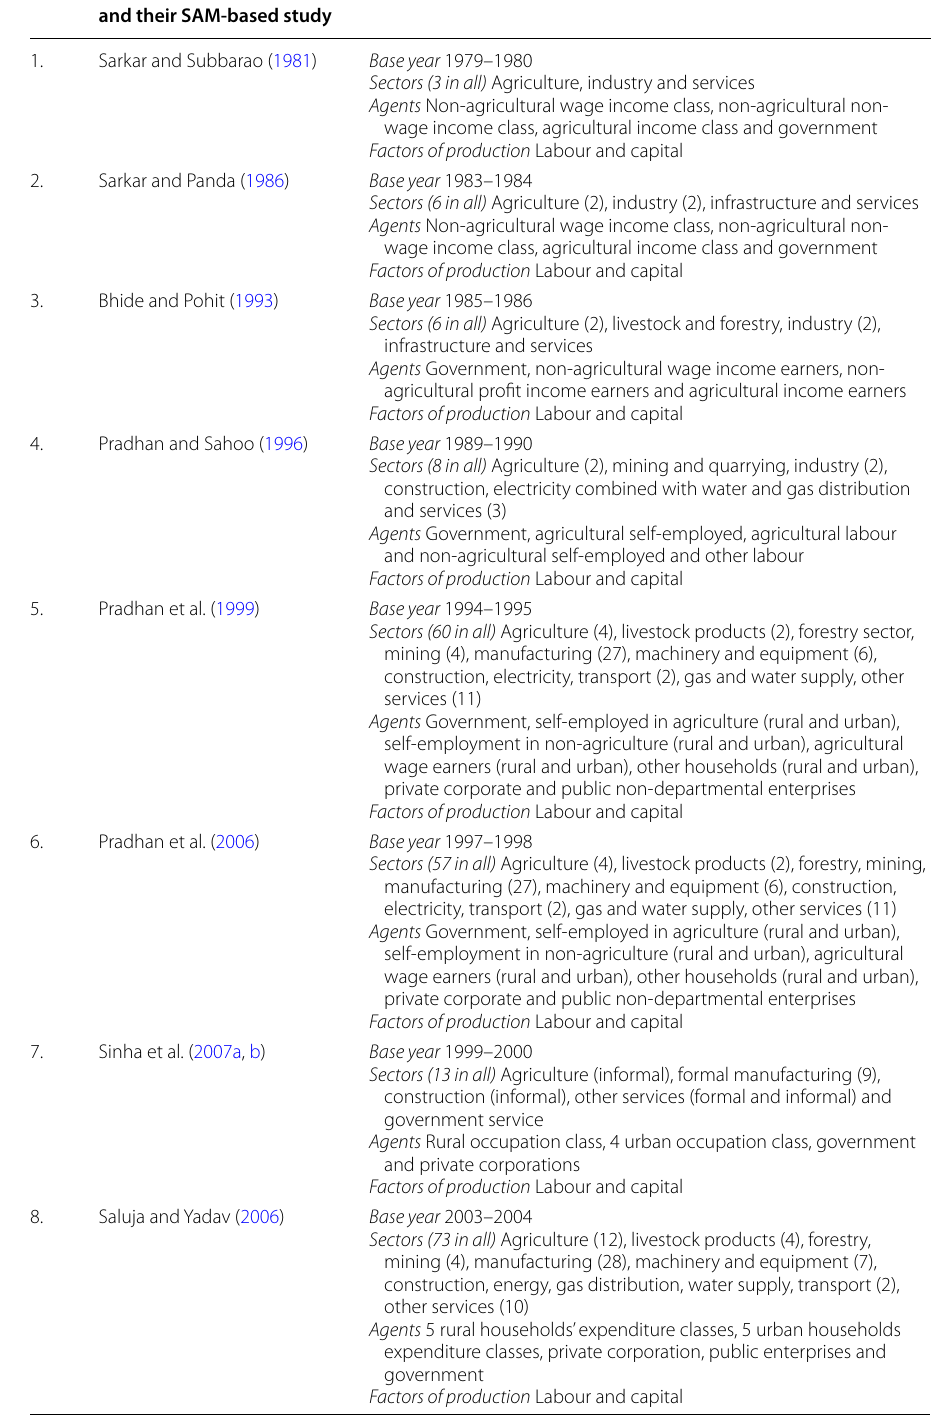
Table 1 Stylized facts of SAMs of India. Source : Pal et al. (2012) S. no. Name of researchers and their SAM-based